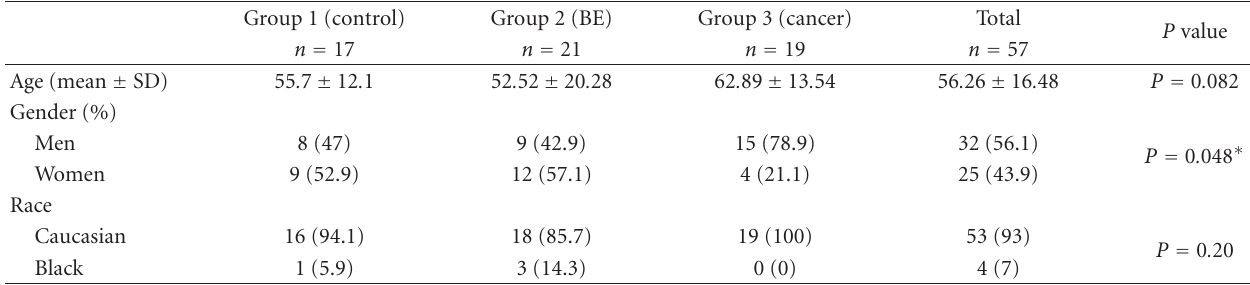
Table 1: Demographic data from patients whose tissue was used to investigate the relationship between expression of the antigen Ki-67 and stages within the metaplasia-adenocarcinoma sequence.